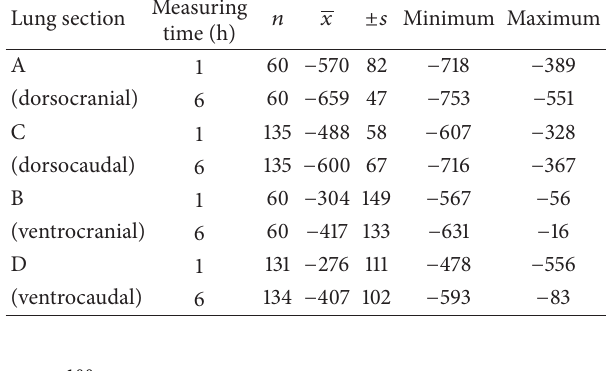
Table 3: X-ray absorption values of lung parenchyma in HU of 15 vital calves in the first hour p. n. (measured data of the dorsal and ventral lung segments).